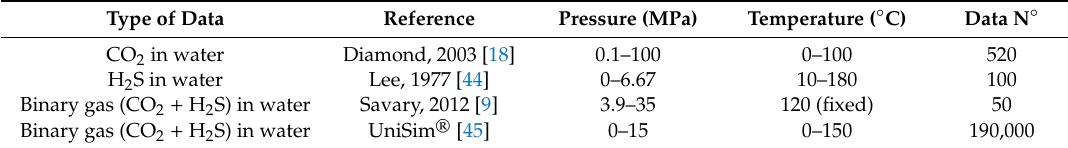
Table 2. List of the reference